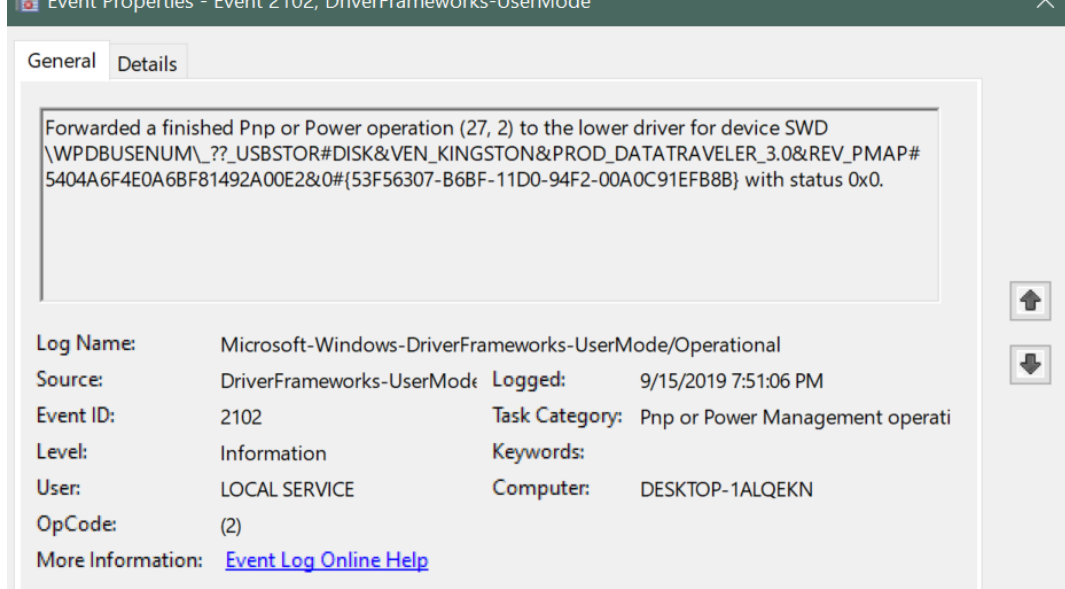
Figure 7. Event ID 2102 for Kingston USB drive.